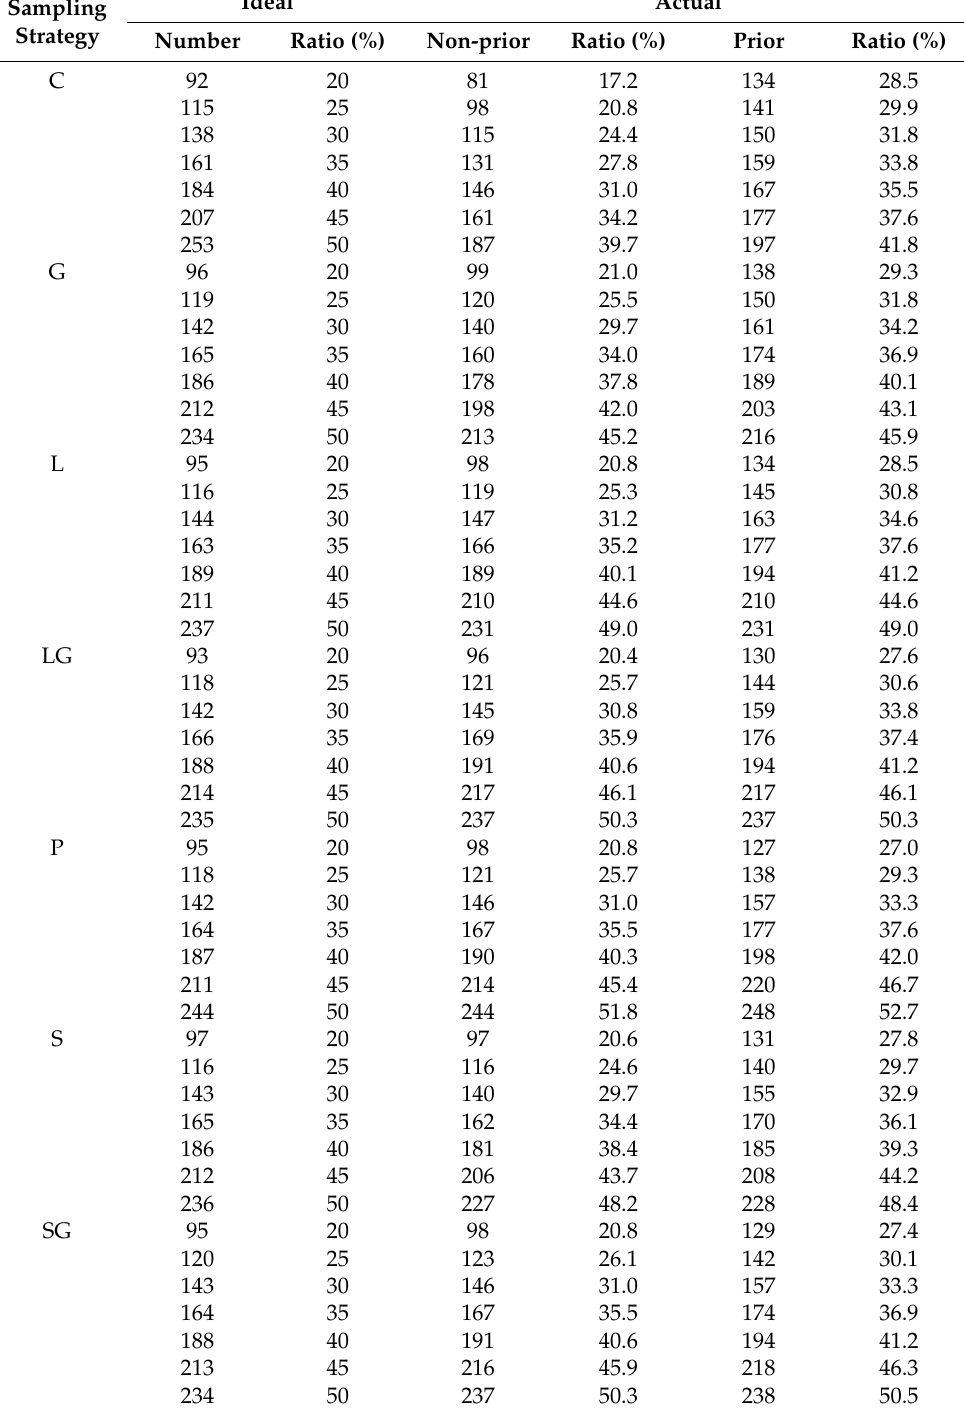
Table 3. The sampling number of the primary core collections within different sampling